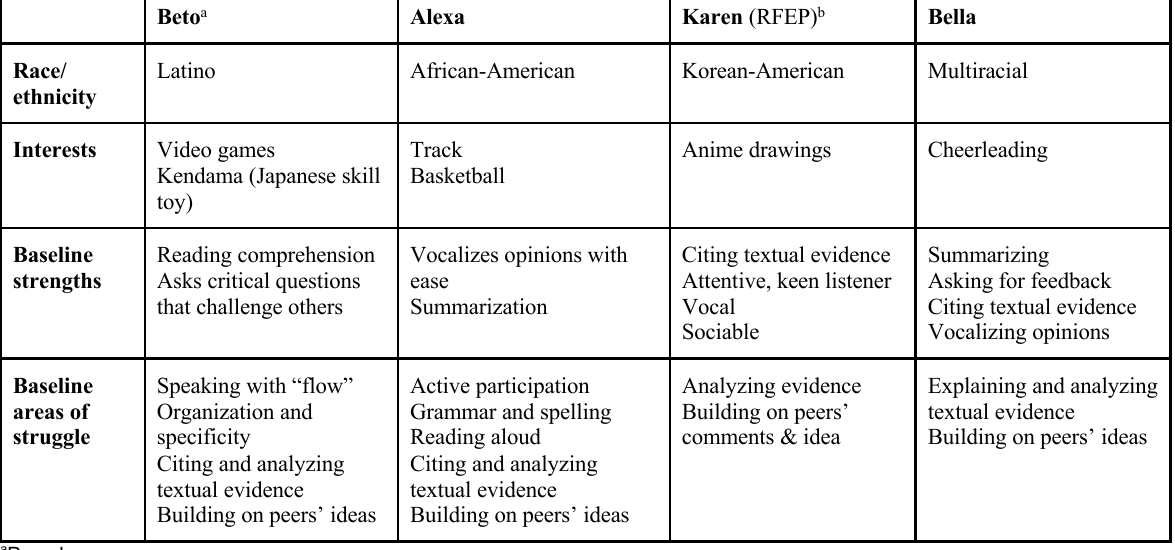
Table 2: Nina’s Discussion Engagement Profiles for her Four Focal